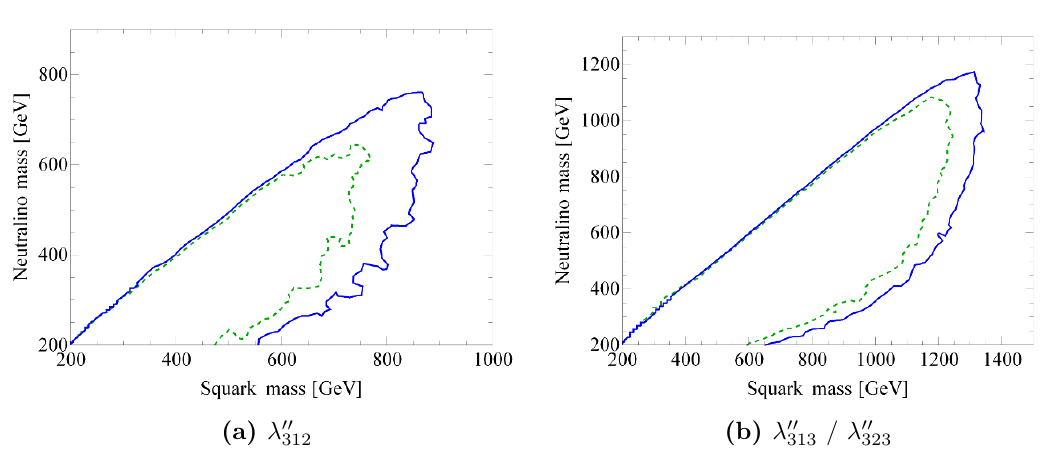
Figure 15. Exclusion curves within the neutralino-squark mass parameter space for a Higgsino-up neutralino. Figure (a) presents (cid:21) 00 green curves assume leading order squark production whereas the solid blue curves include MSSM